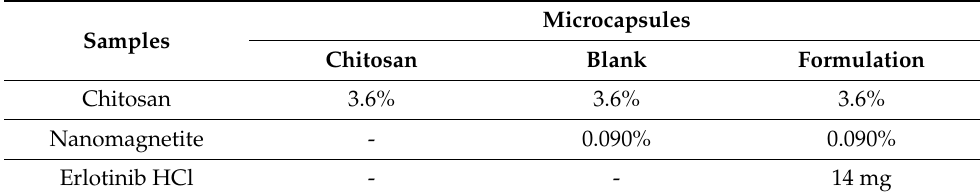
Table 1. Component